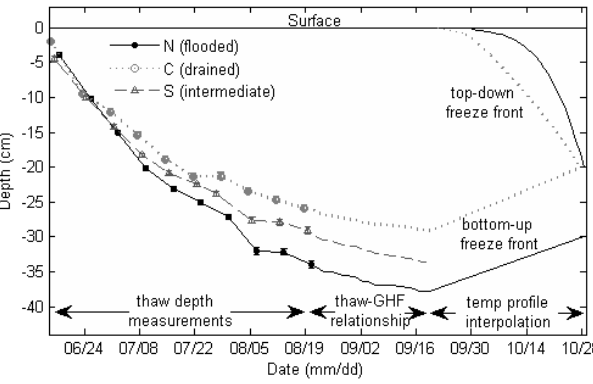
Figure 3. Thawing and freezing fronts measured during the growing season and simulated for 2 Fig. 3. Thawing and freezing fronts measured during the grow- the autumn. Points indicate thaw depth measurements and lines show simulated thawing and 3 ing season and simulated for the autumn. Points indicate thaw freezing fronts. From 19 August to 19 September, the thawing front was simulated with 4 depth measurements and lines show simulated thawing and freez- ing fronts. From 19 August to 19 September, the thawing front was ground heat flux measurements. After 19 September, the thawing and freezing fronts were 5 simulated with ground heat flux measurements. After 19 Septem- reconstructed by interpolating between the dates when the temperature at a specific soil depth 6 ber, the thawing and freezing fronts were reconstructed by inter- decreased consistently below 0 °C. Error bars show standard error of the mean. 7 polating between the dates when the temperature at a specific soil depth decreased consistently below 0 ◦ C. Error bars show standard error of the